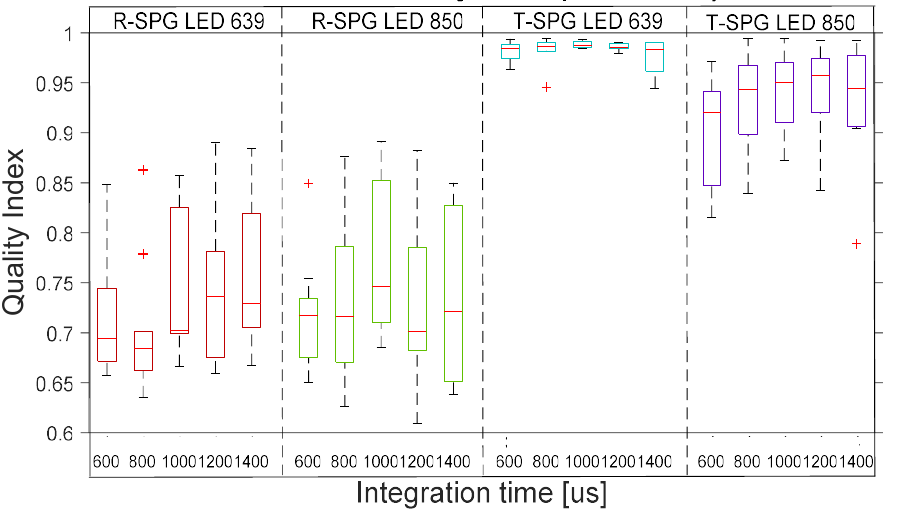
Figure 16. Boxplots of quality index of rSPG signals with 4 different lights at 5 integration times with non-coherent light in transmission and reflection. The inner box divisions indicate: Q1 (the first quartile) to Q3 (the third quartile). The median is marked by a line across the box. The “whiskers” indicate results from Q1 and Q3 to the most extreme data points. The + symbols represent outliers.